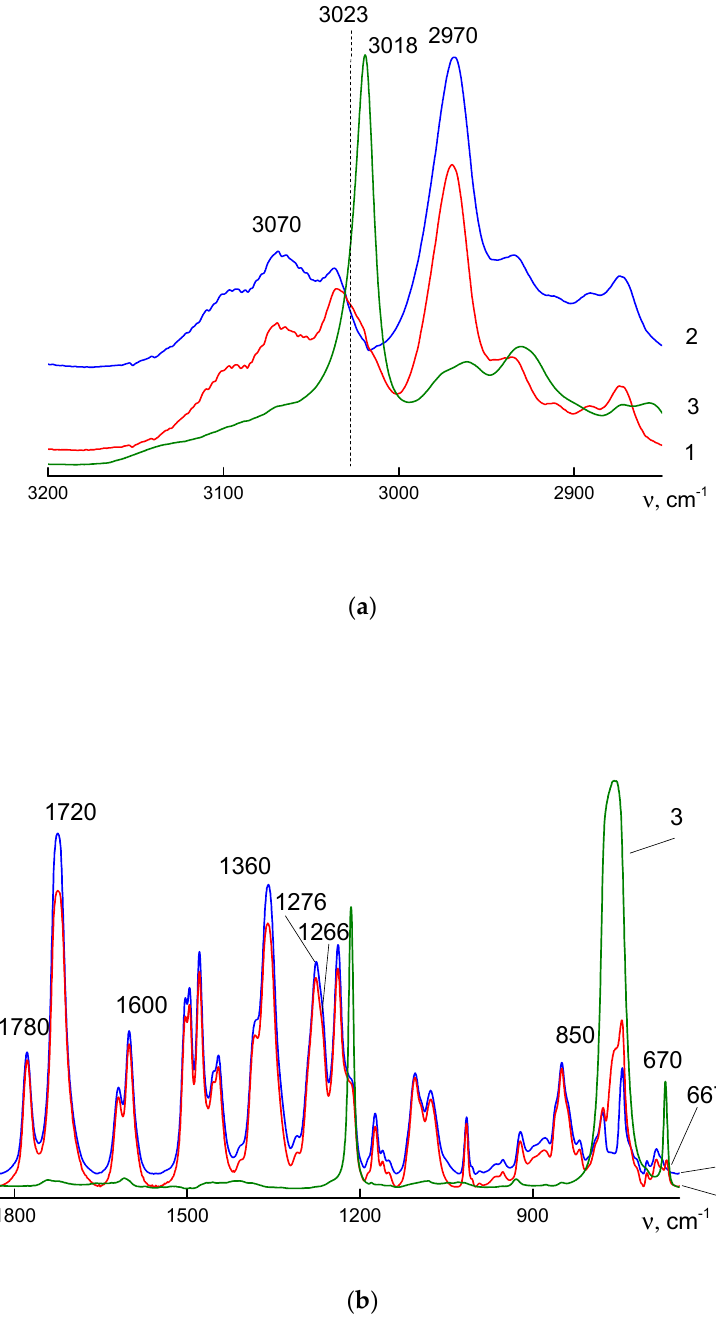
Figure 2. IR-spectra for films of Ultem before (curve 1 ) and after ethanol treatment (curve 2 ) at CH-stretching vibrations absorption region ( a ) and at “fingerprinting” region ( b ) in comparison with CHCl 3 spectrum (curve 3